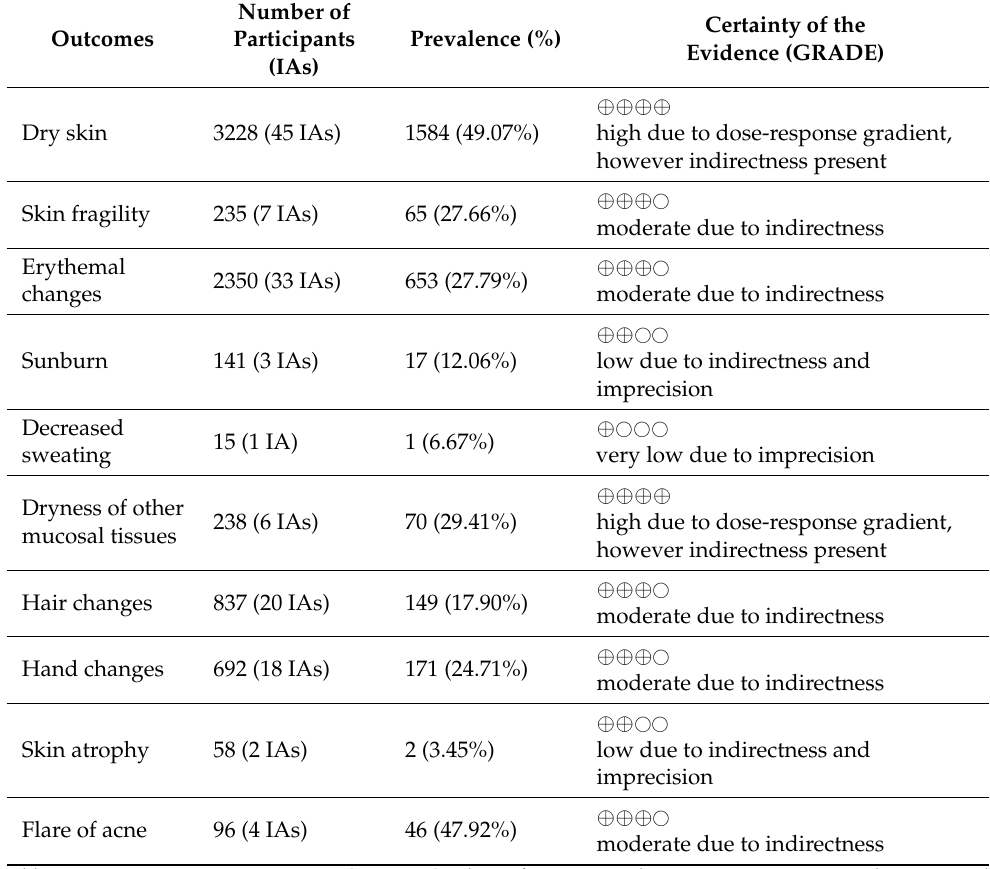
Table 3. Summary of ISO therapy adverse events: whole skin